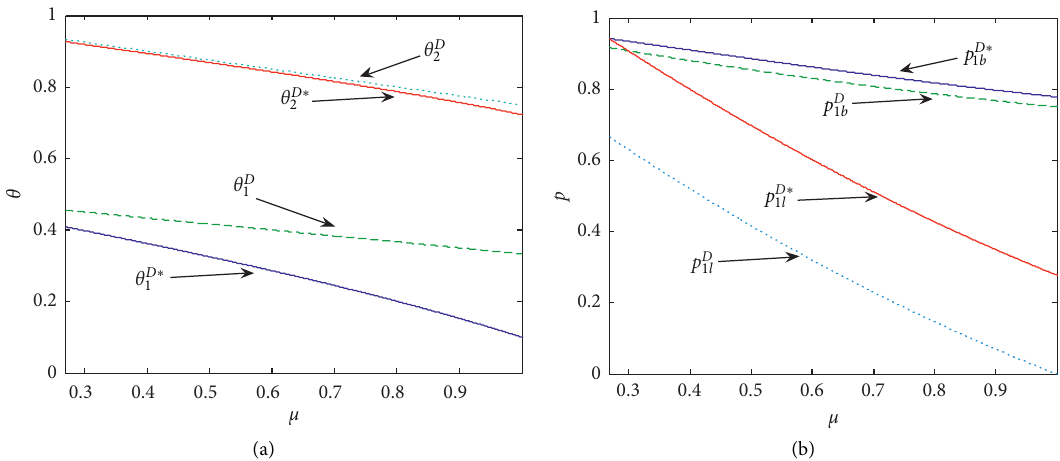
Figure 3: (a) The changes of the location of the marginal consumer with μ . (b) The changes of prices of the high-quality firm’s products with μ (dotted line: τ � 0 and solid line τ � 0 .